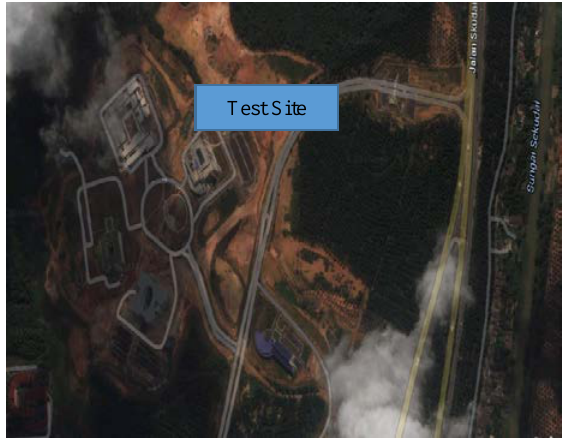
Figure 4 . Site Location (Source: Google Map,